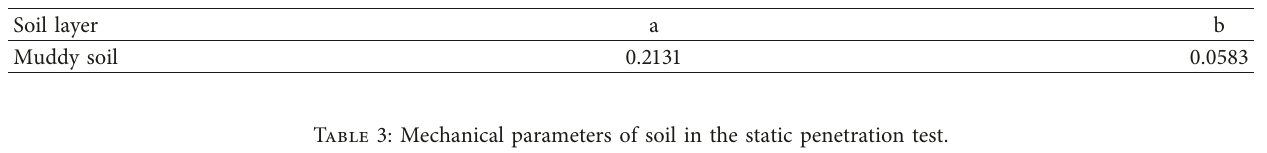
Table 2: Values of the linear relationship parameters.